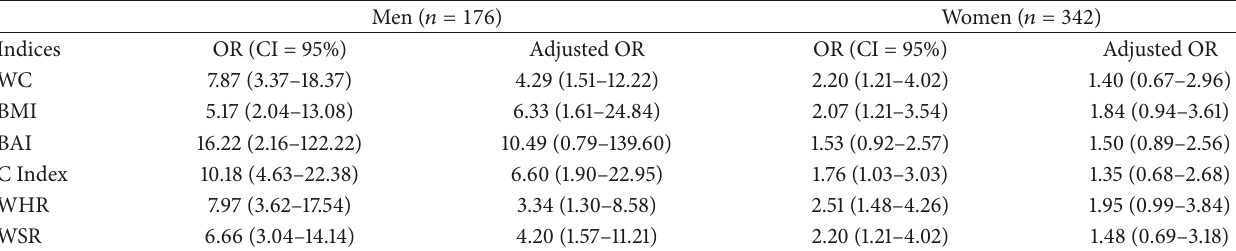
Table 2: Odds ratios (OR, confidence interval: 95%) for